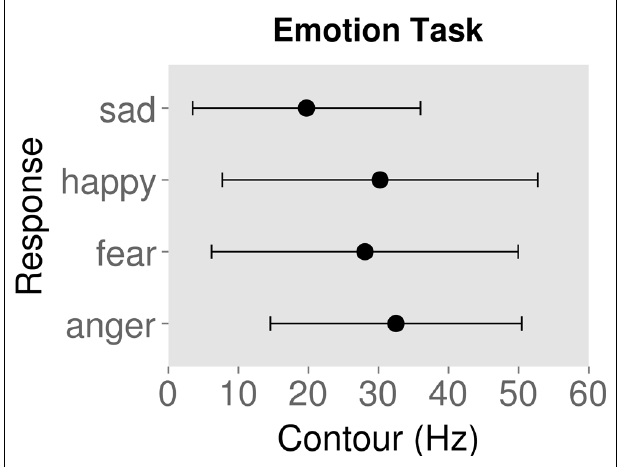
FIGURE 3 | Mean contour (measured as standard deviation of fundamental frequency) and standard deviation for behavioral responses to rating stimuli by emotion